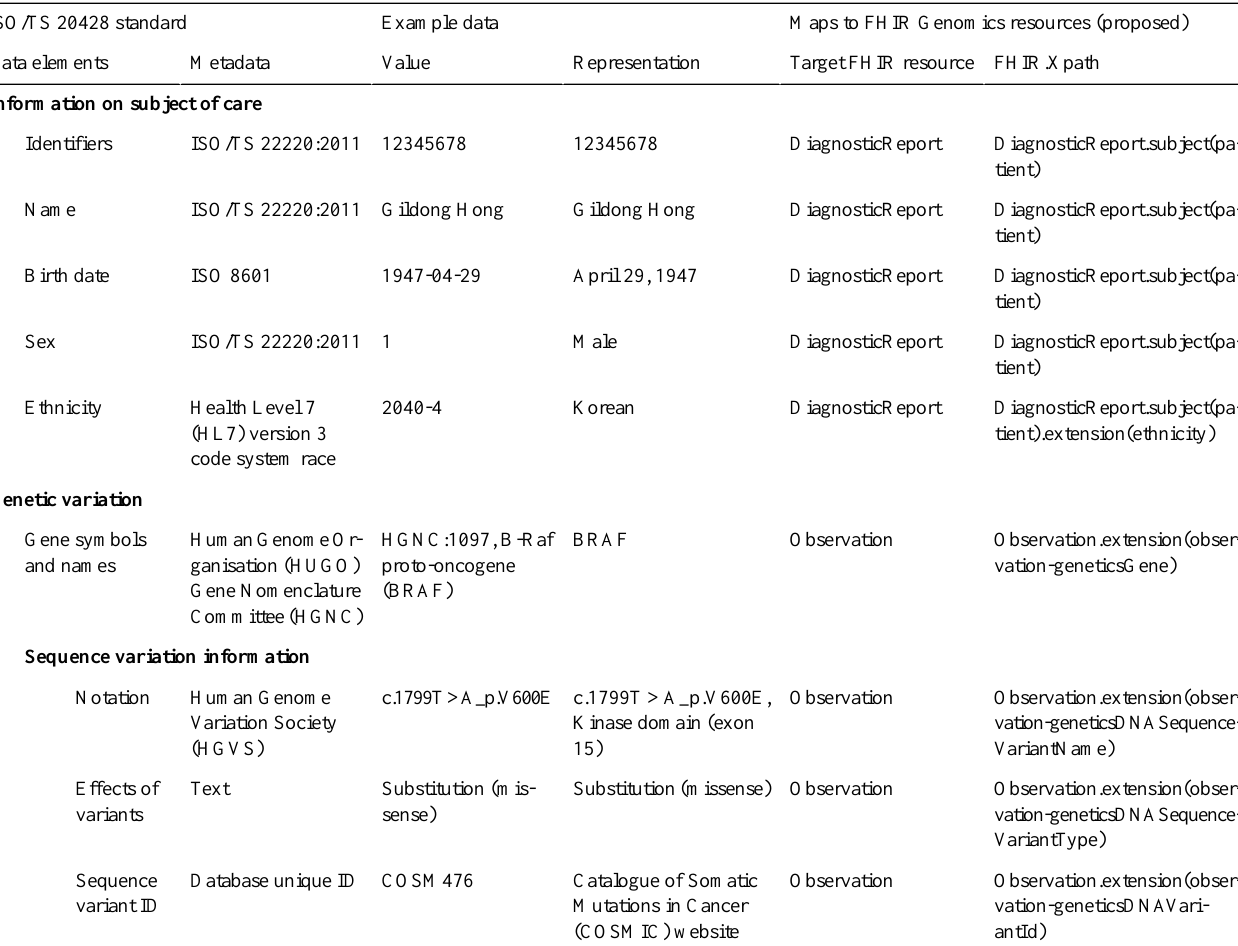
Table 1. Specification example of the International Organization for Standardization Technical Specification (ISO/TS) 20428 standard and the Fast Healthcare Interoperability Resources (FHIR) Genomics resources.